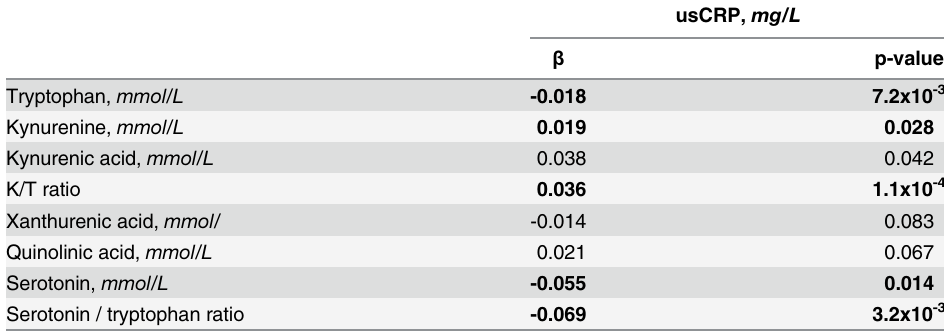
Table 2. Association between usCRP and serum concentration of tryptophan, kynurenine, kynurenic acid, serotonin, K/T ratio and serotonin over tryptophan ratio.